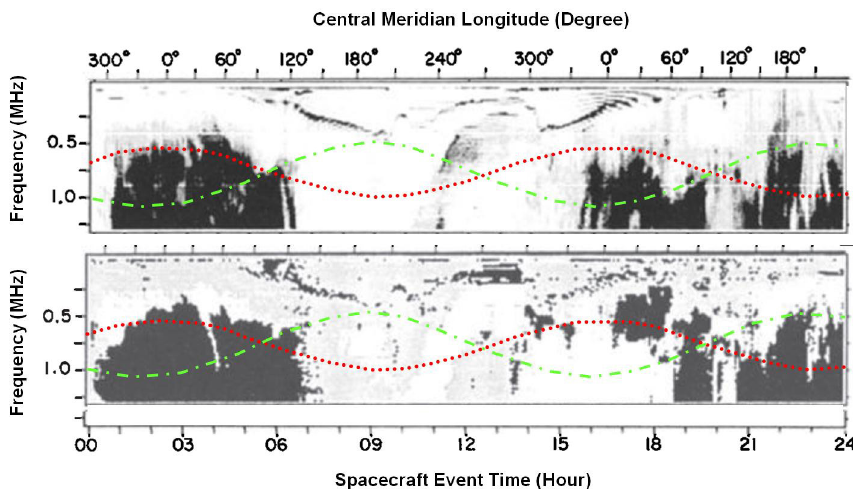
Figure 4. Daily dynamic spectrum recorded on 5 March 1979, by the Planetary Radio Experiment onboard the Voyager-1 spacecraft. The Voyager-1’s closest approach was at about 12:00 spacecraft event time. The total power and the polarization are displayed in the top and bottom panels, respectively. We overlap to the Voyager dynamic spectrum two curves taken from the bottom panel of Fig. 3. The red and the green curves indicate the variation of the HOM extinction-fitted frequencies related to the emissions coming from the northern and southern hemispheres,